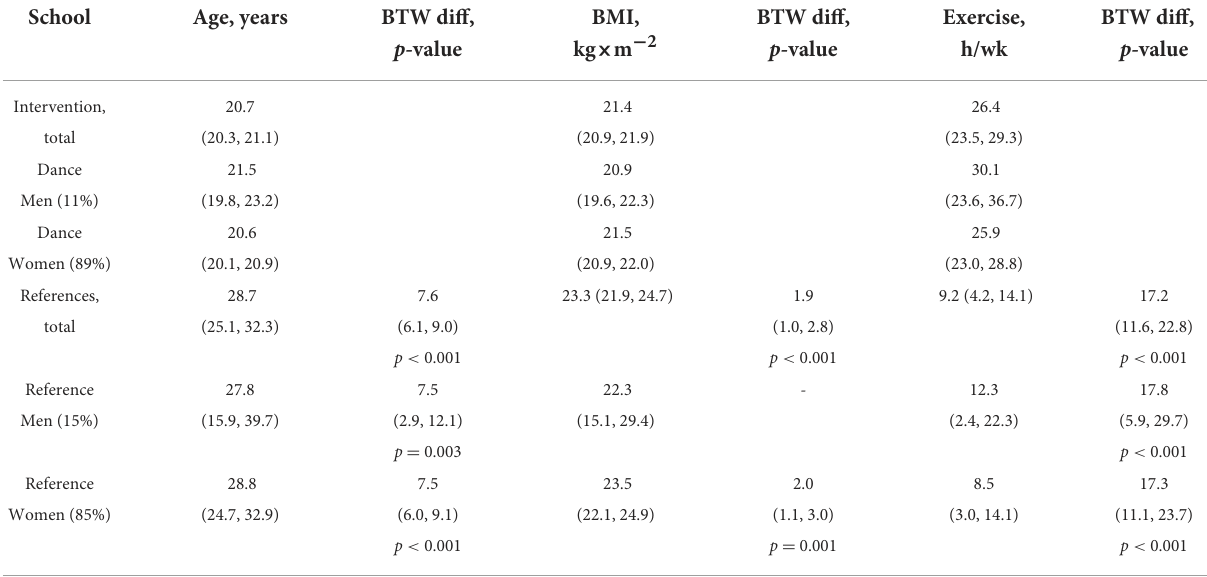
TABLE 1 Baseline demographics of participants; values are mean (99% CI) and comparisons are made between groups and separately for sexes between the two